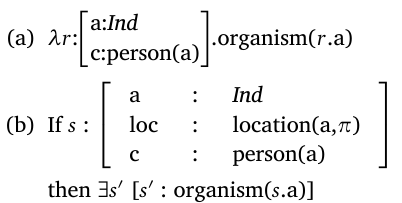
Figure 9: Representing functional knowledge